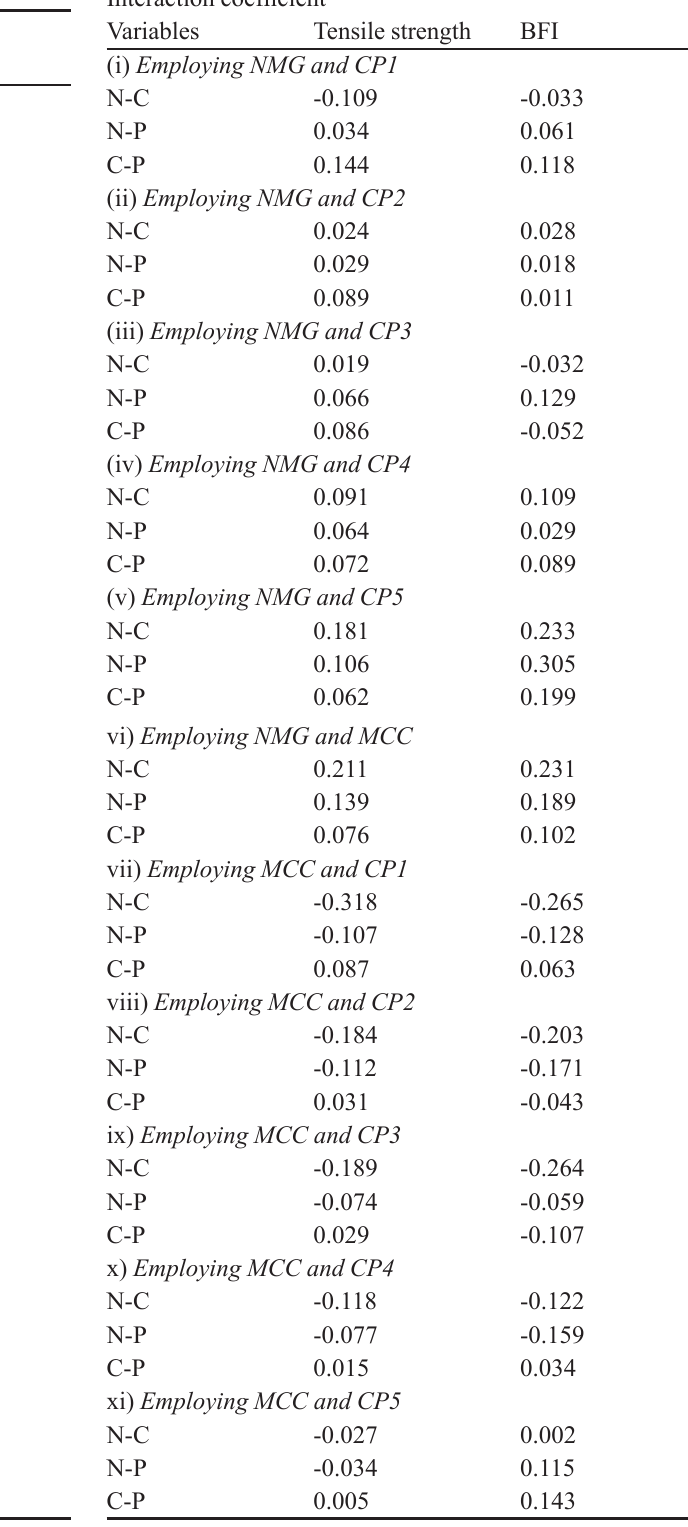
TABLE IV - Quantitative effect of nature of binder (N), concentration (C) and applied pressure (P) on the tensile strength and brittle fracture index values of paracetamol